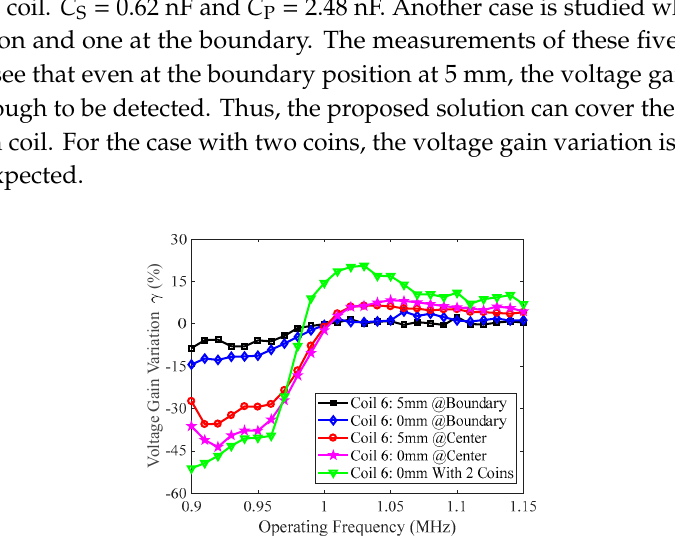
Figure 18. Measurements of γ varying with f for Coils 1, 4, and 6.